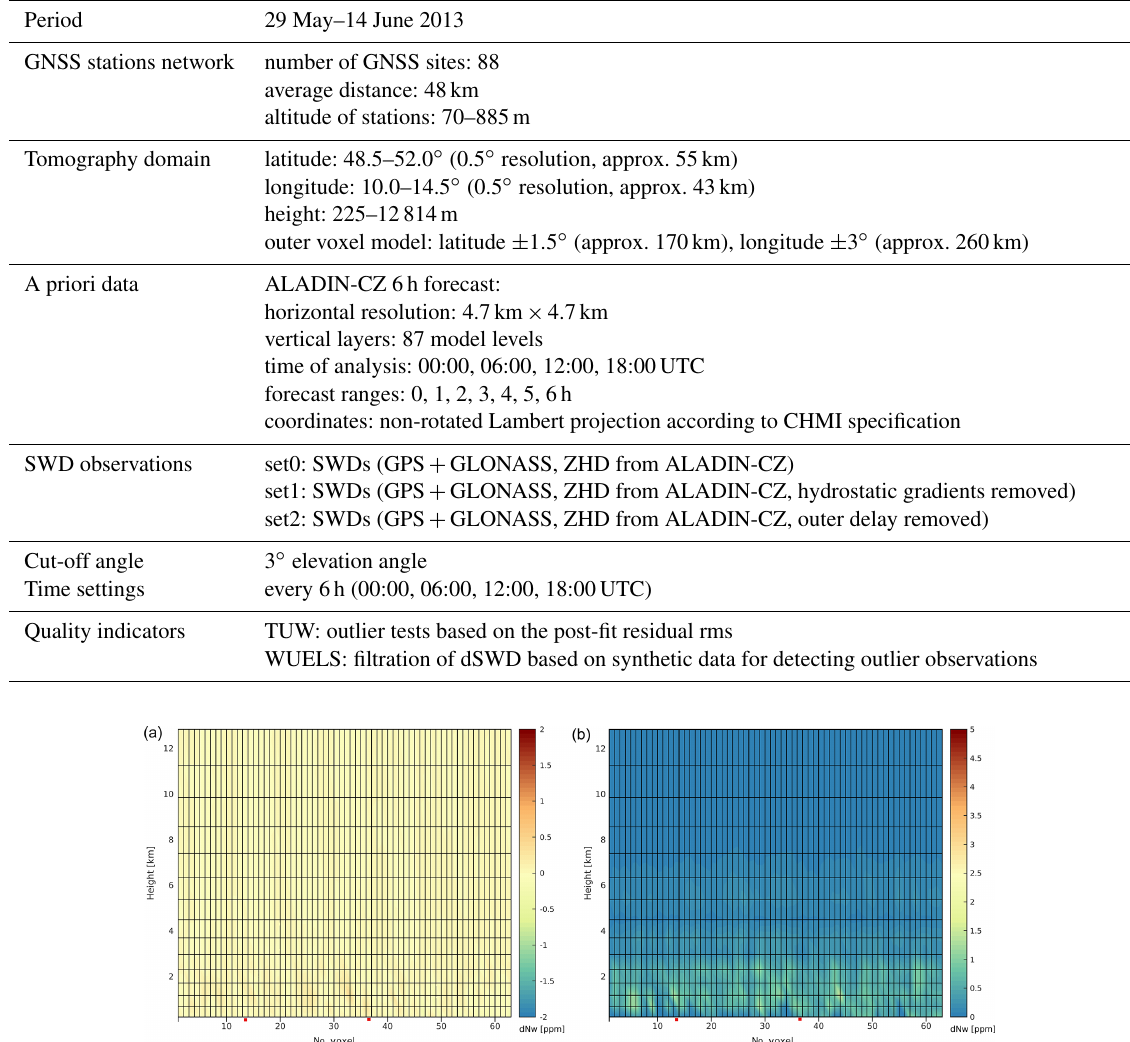
Figure 3. Bias (a) and standard deviation (b) of the differences in wet refractivity (ppm) between TUW set0 and TUW set1. Analysed period: 29 May–14 June 2013 (68 epochs). Red squares denote location of the RS